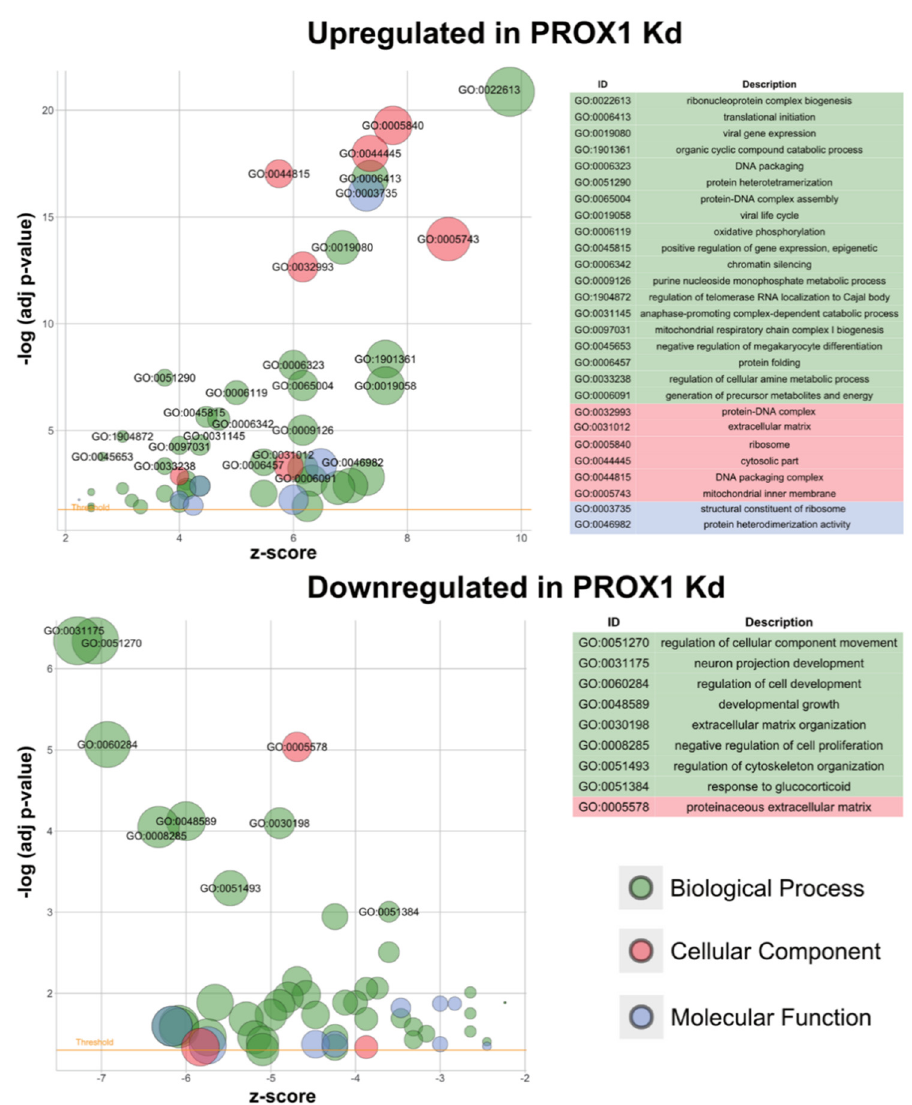
Figure 4. Bubble plots of significantly enriched Gene Ontology (GO) terms for the PROX1- depleted CGTH-W-1 cells. The cut-off for labelling was set at an adjusted p -value of 0.001. The z-score (horizontal axis) indicates whether the given term in more likely to be up- or down-regulated. The area of the displayed circles is proportional to the number of genes assigned to the term in the analysis. The threshold indicates the adjusted p -value of 0.05.